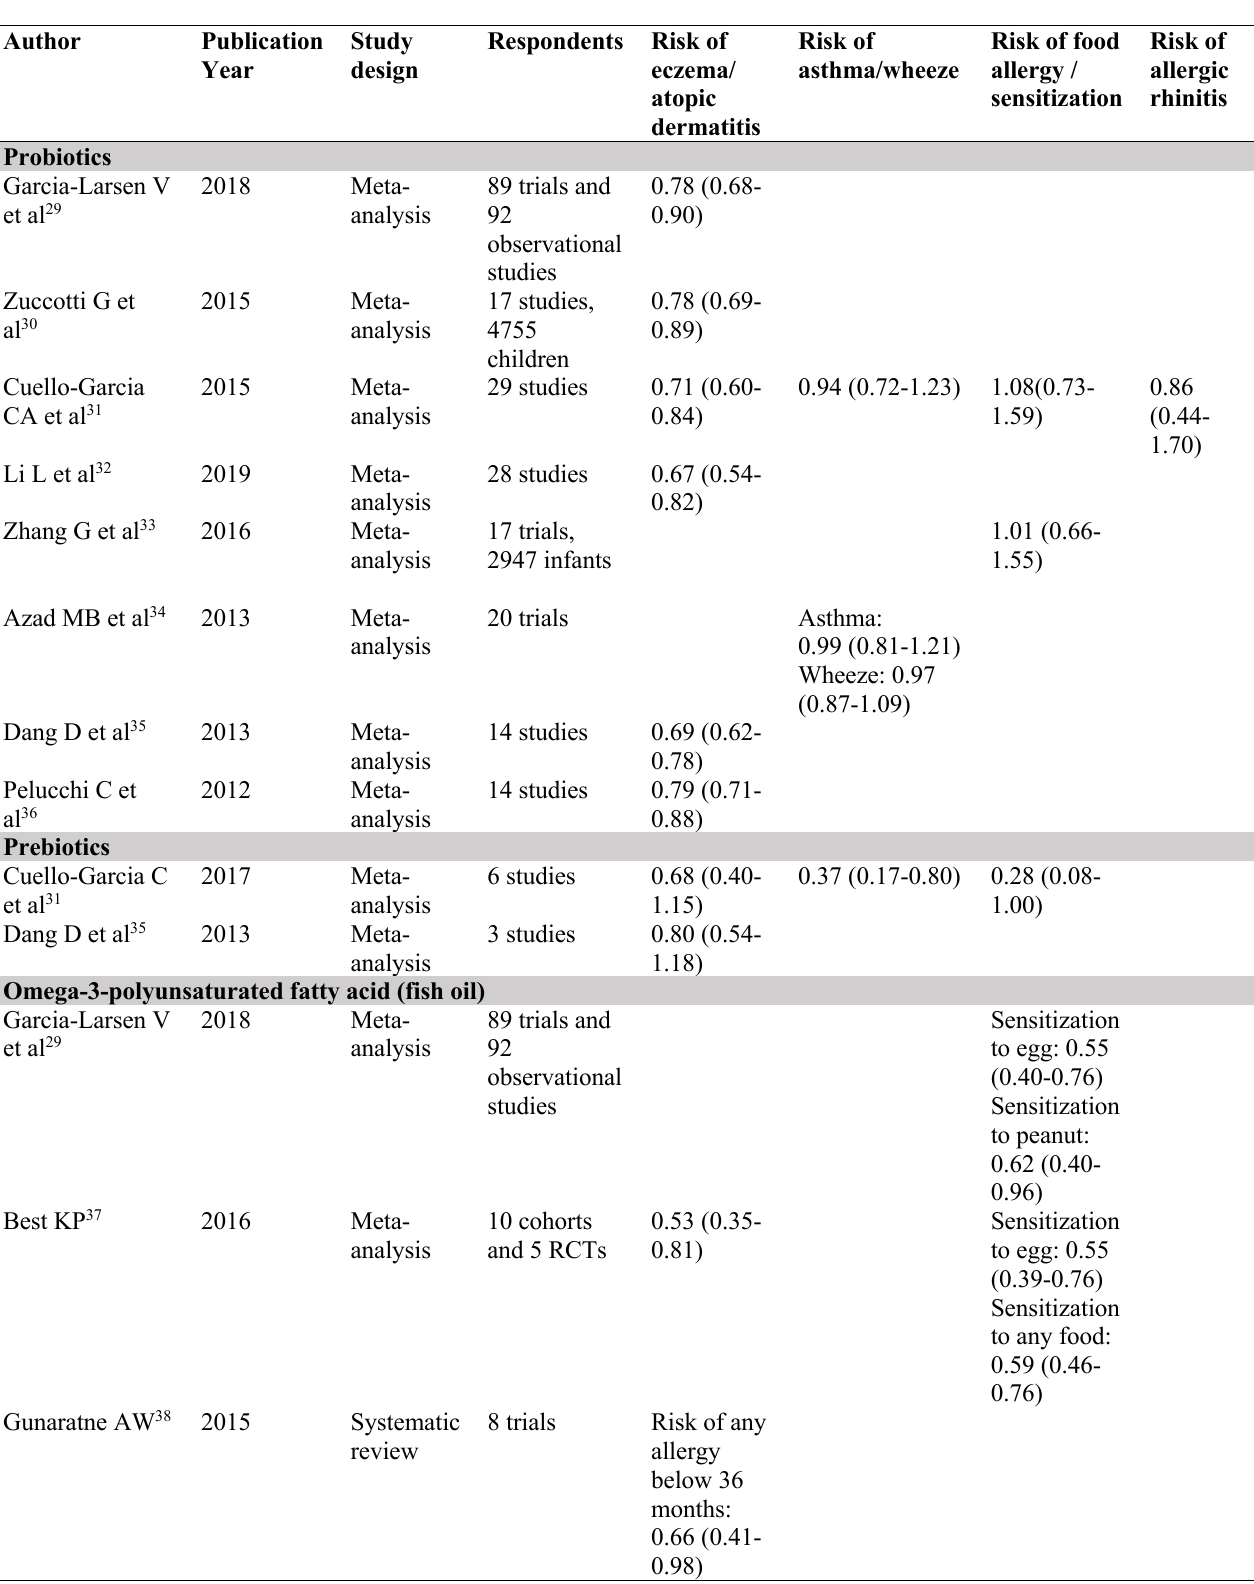
Table 2. Effect of maternal diet during pregnancy to reduce allergy risk in